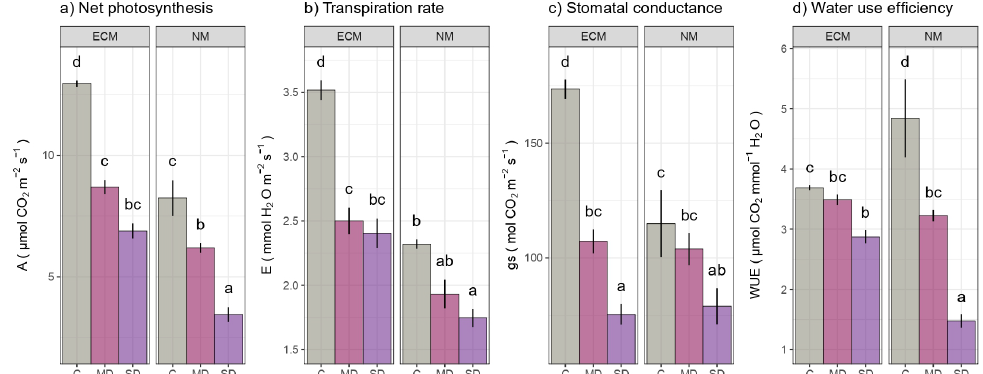
Figure 2. The effects of mycorrhization and/or drought on gas exchange: ( a ) net photosynthetic rate (A; mmol CO 2 m − 2 s − 1 ), ( b ) Transpiration rate (E; mmol H 2 O m − 2 s − 1 ), ( c ) Stomatal conductance (gs, mmol CO 2 m − 2 s − 1 ), ( d ) Water use efficiency (WUE; mmol CO 2 mmol − 1 H 2 O) of leaves of Q. robur . Treatments: C-control regularly watered oak seedlings, MD-oak seedlings exposed to the mild drought that corresponds with 60% of soil water field capacity, SD- oak seedlings exposed to the severe drought that corresponds with 30% of soil water field capacity ECM-oak seedlings inoculated with ectomycorrhizal inoculum, and NM-oak seedlings not inoculated with ectomycorrhizal inoculum. Different small letters indicate significant differences across the different treatments; Tukey’s honestly significant difference (HSD) post hoc test ( p ≤ 0.05). Data represent the mean ± standard deviation (SD).